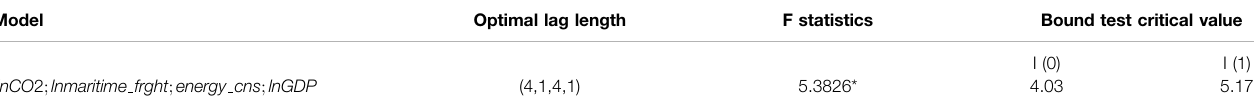
TABLE 9 | ARDL bound test results of Denmark.